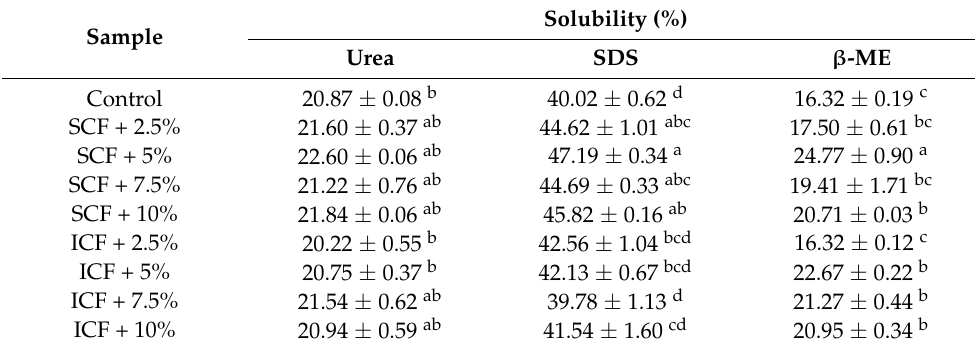
Table 1. Effect of different denaturants on the solubility of MP gels.